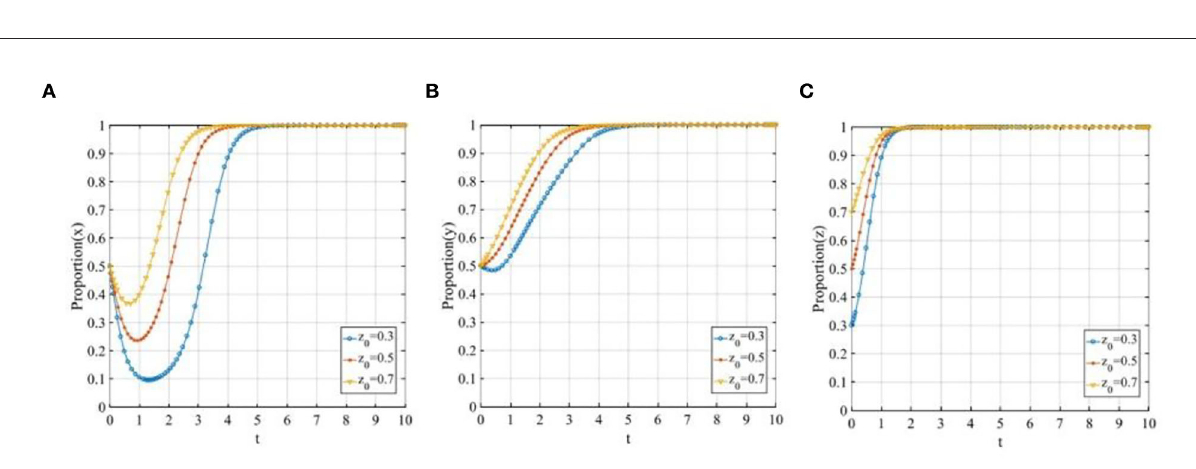
FIGURE6 The evolutionary trajectories of three participants when z 0 = 0.3, 0.5, 0.7. (A) The sensitivity of P2P lending platforms; (B) The sensitivity of investors; and (C) The sensitivity of financial